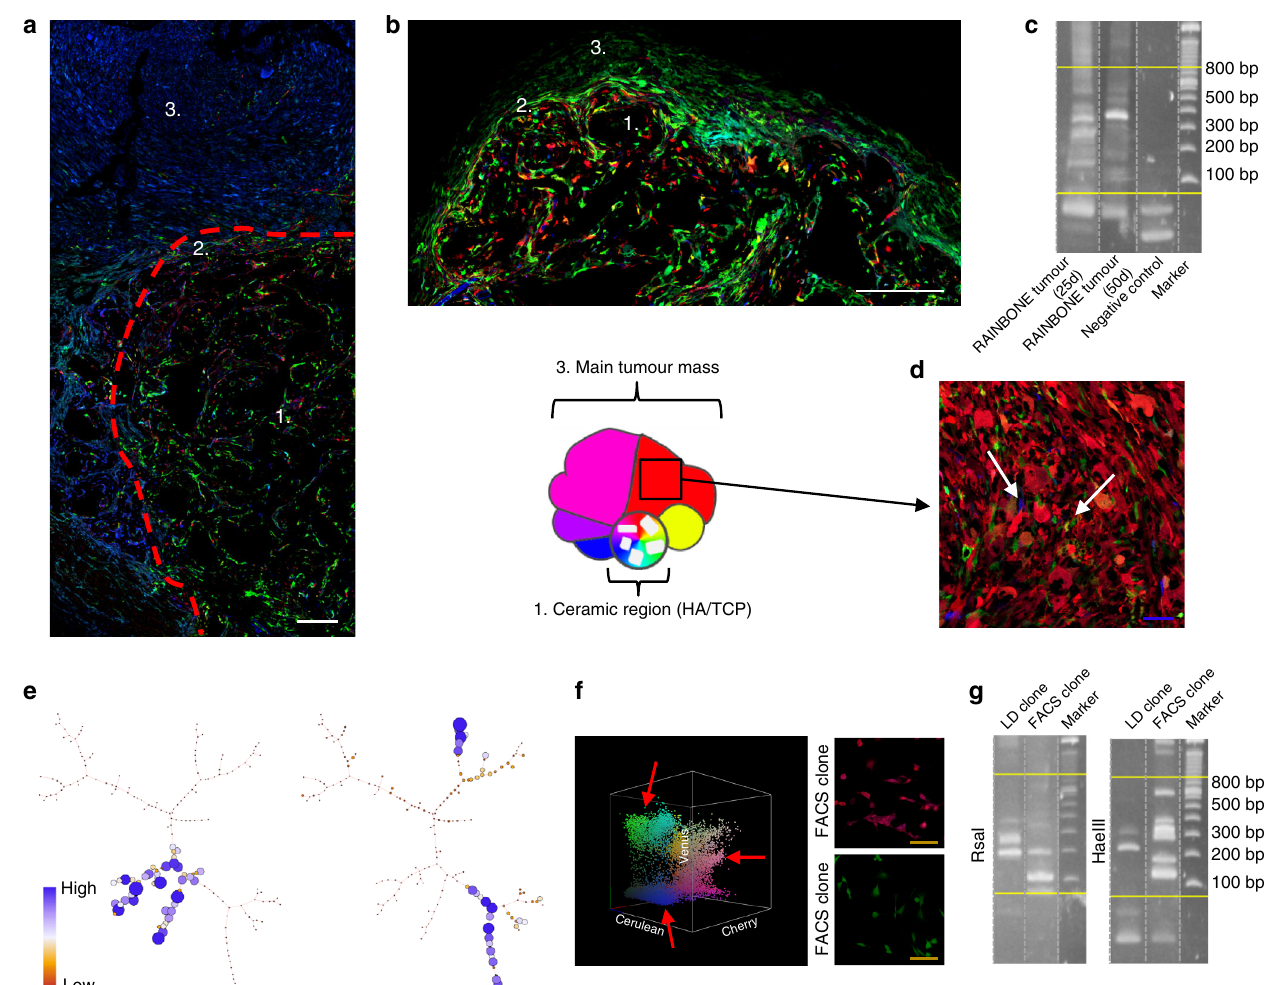
Fig. 3 RAINBONE tumours showed dominant clones in the long term. a Representative image of tumours 50 days after RAINBONE inoculation ( n = 14). 1, Primary implantation site (HA/TCP ceramic region) showing polyclonal evolution; 2, transition zone; 3, large monoclonal areas generated outside of the ceramic region (extracompartmental region). b For comparison, representative image of tumours at 25 days, with tumour growth starting in the extracompartmental region. c LAM-PCR analysis showing the rich ampli fi cation of different provirus integration sites in both short- and long-term RAINBONE tumours. Negative control = water. d Representative detailed image of tumour heterogeneity present in the large clonal area. Low-frequency clones are indicated by white arrows. e Representative SPADE tree clonal composition of RAINBONE tumours at 50 days. Note that in this case, colours represent the population frequency. f Representative 3D fl ow cytometric RAINBONE tumour analysis at 50 days ( n = 4). Arrows indicate the most frequent clones that were subsequently FACS sorted (right). g LAM-PCR analysis showing the monoclonal origin of FACS sorted clones ( n = 3). White bar = 200 µ m; orange bar = 100 µ m; blue bar = 50 µ